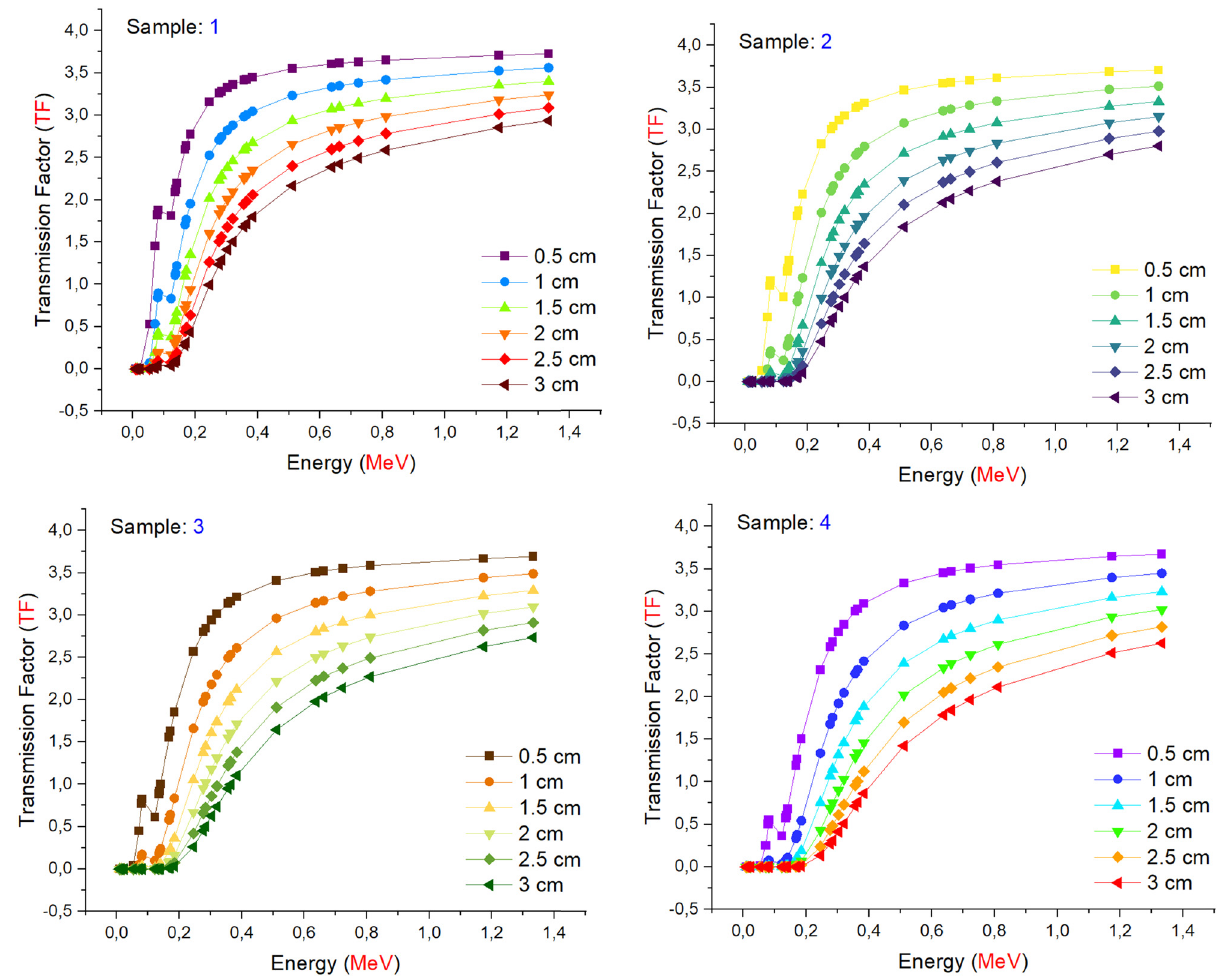
Figure 15: TFs of investigated glasses as a function of used radioisotope energy ( MeV ) at di ff erent glass